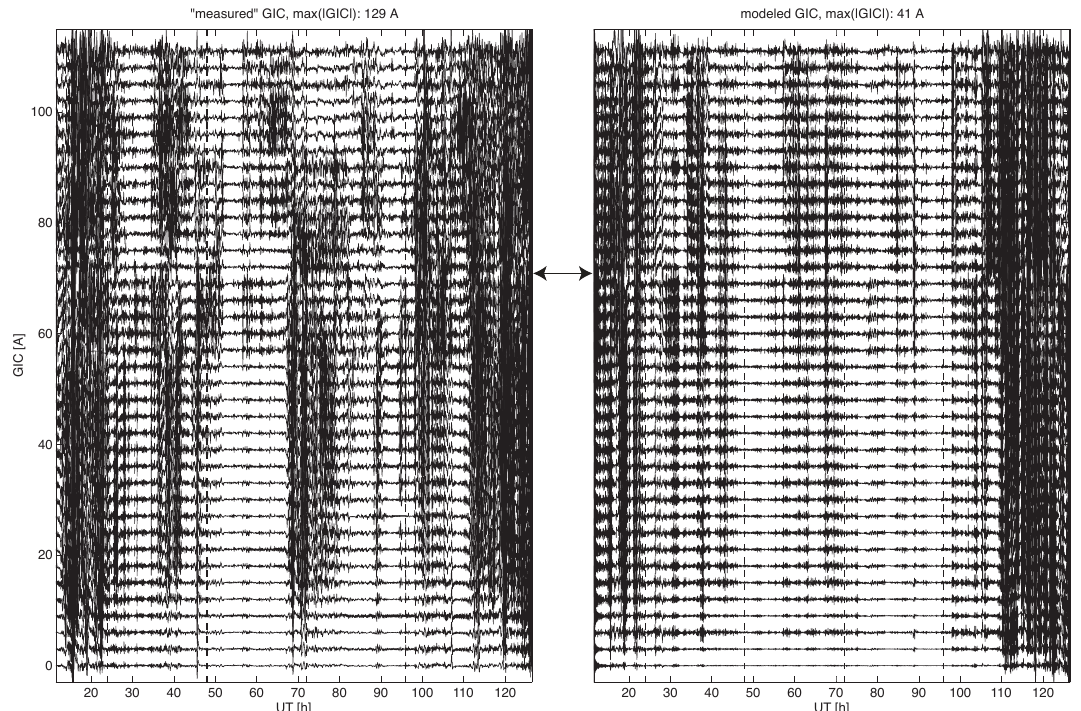
Fig. 6. “Measured” (see the text for explanation) and the modeled GIC at stations shown in Fig. 3. Arrow in between the panels shows the separation between stations west of the Greenwich meridian (up from the arrow) and east of the Greenwich meridian (down from the arrow). Both sets are arranged from the geographically southernmost (bottom) to the northernmost (top) station. The time is UT hours from the beginning of 24 October 2003. The vertical dashed lines indicate the beginning of each new UT